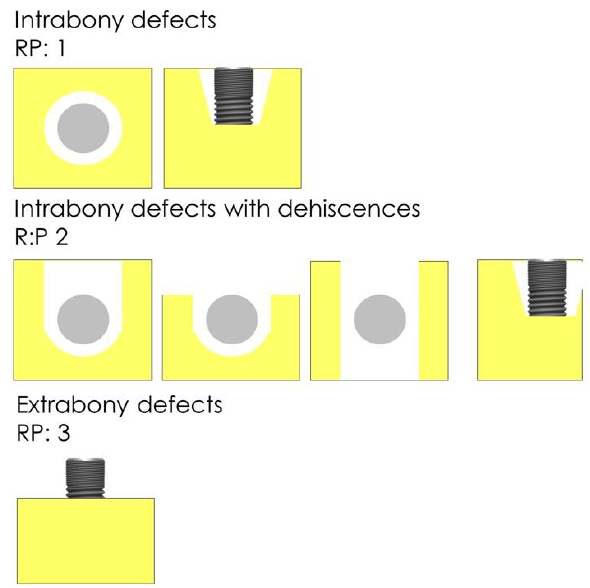
Figure 4. RP Classification of peri-implant bone defects based on risk-chance ratio of treatment. 195